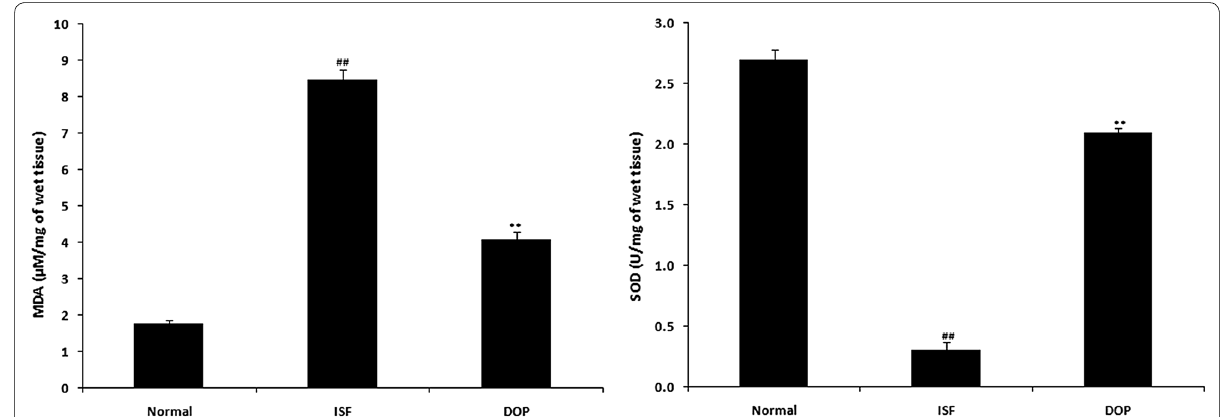
Fig. 5 Desoxyrhapontigenin ameliorates the level of oxidative stress in the brain tissues of rats with anaesthesia-induced neuronal injury. Mean SEM (n 15); ## p < 0.01 vs. controls; ** p < 0.01 vs. ISF ± =